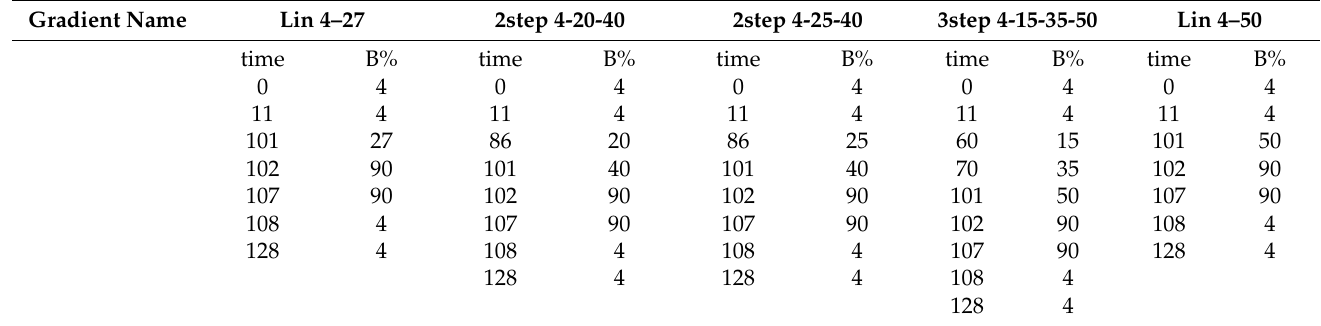
Table 6. Gradient programs used during the optimization of the chromatographic